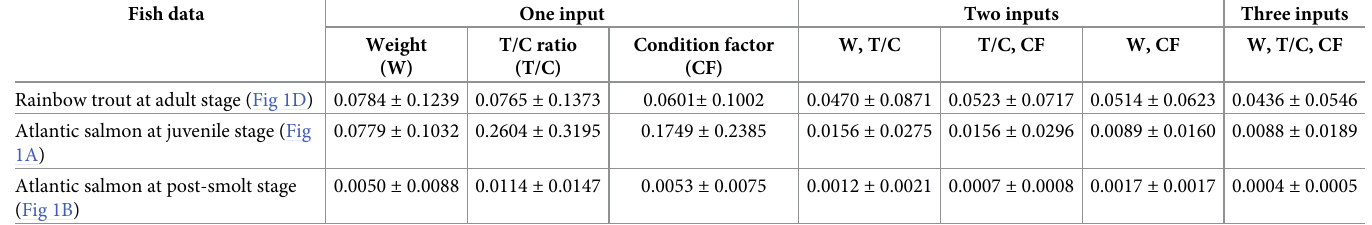
Table 2. Mean square errors (MSEs) for different input combinations (one input, two inputs, or three inputs) of our computational models with a reservoir network size of 50 hidden neurons. The MSE is calculated from the target (or real) SGR and the predicted (or estimated) SGR values shown in Figs 6 and 7. Fish data